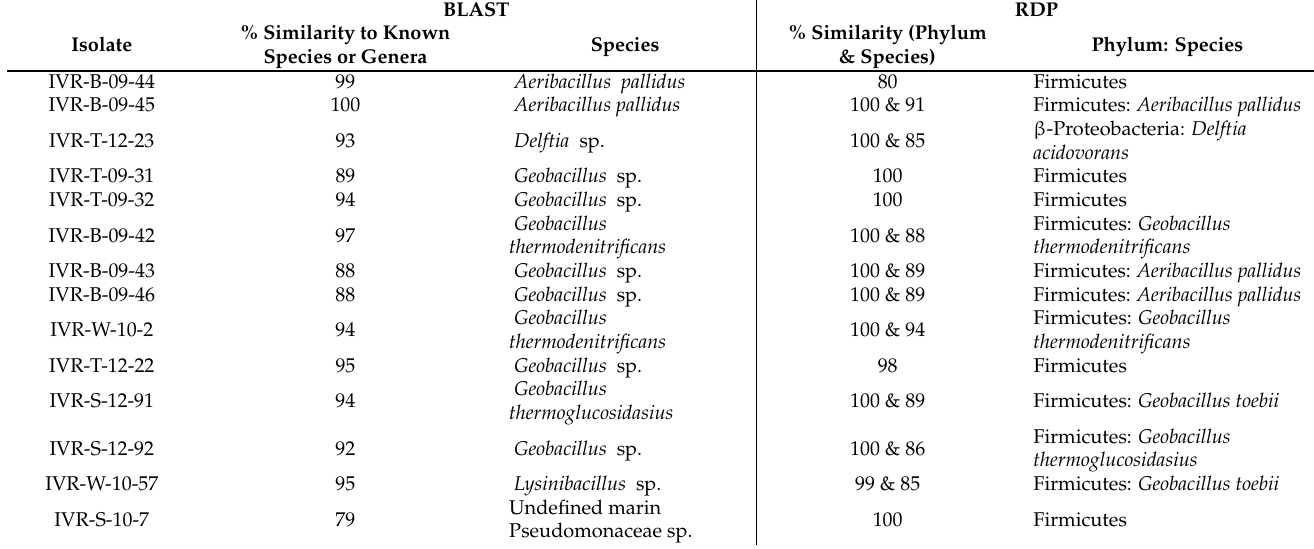
Table 2. Taxonomic assignments of isolated cultured thermophilic bacteria from the Veracruz Reef System. Only species identities >75% are indicated. IVR: Isla Verde Reef; BLAST: Basic Local Alignment Tool; RDP: Ribosomal Database